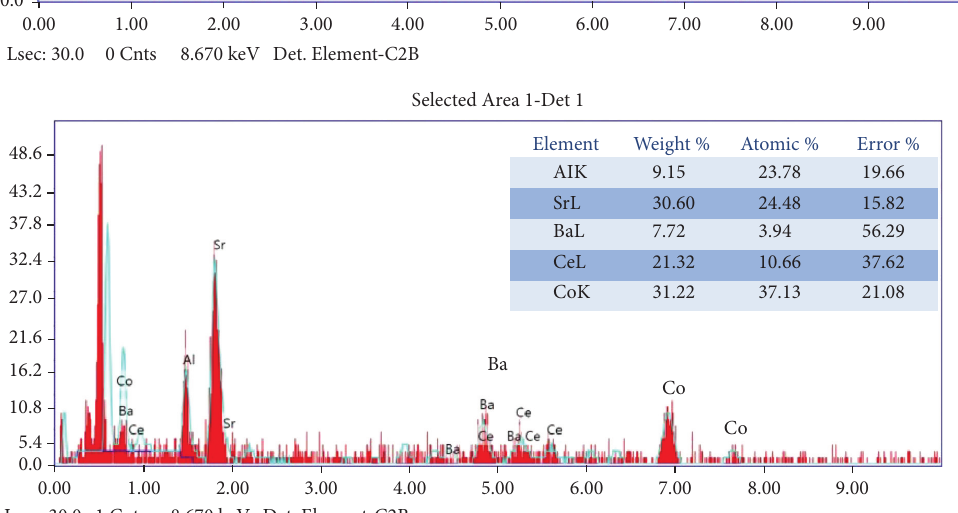
Figure 8: EDAX details of cordierites. (a) Uncoated. (b) COAT 1. (c) COAT